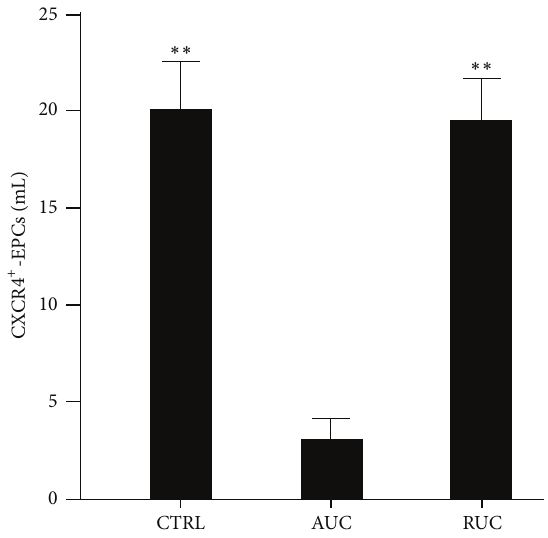
Figure 2: Circulating CXCR4-positive endothelial progenitor cells (CXCR4 + -EPCs) levels in each study group (CTRL = controls; AUC = active ulcerative colitis; RUC = remitting ulcerative colitis). Data are shown as means ± standard error means. Statistical significance was calculated with a univariate ANOVA and post hoc test for multiple comparisons. Statistical difference in RUC patients and controls with respect to AUC group is indicated by ∗∗ ( 𝑃 < 0, 001